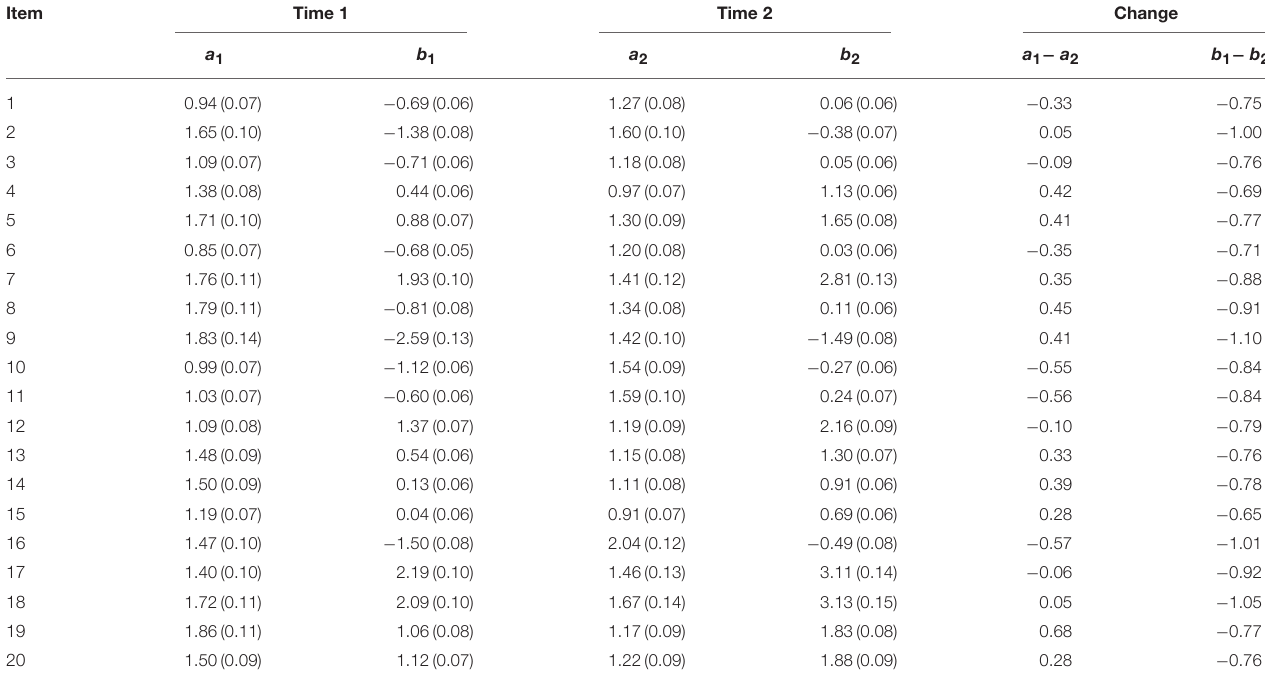
TABLE 6 | Fitting data generated from mixture IRT to unidimensional 2PL IRT model: Condition 1 (Increase in item difficulty for Group 1 at Time 2).